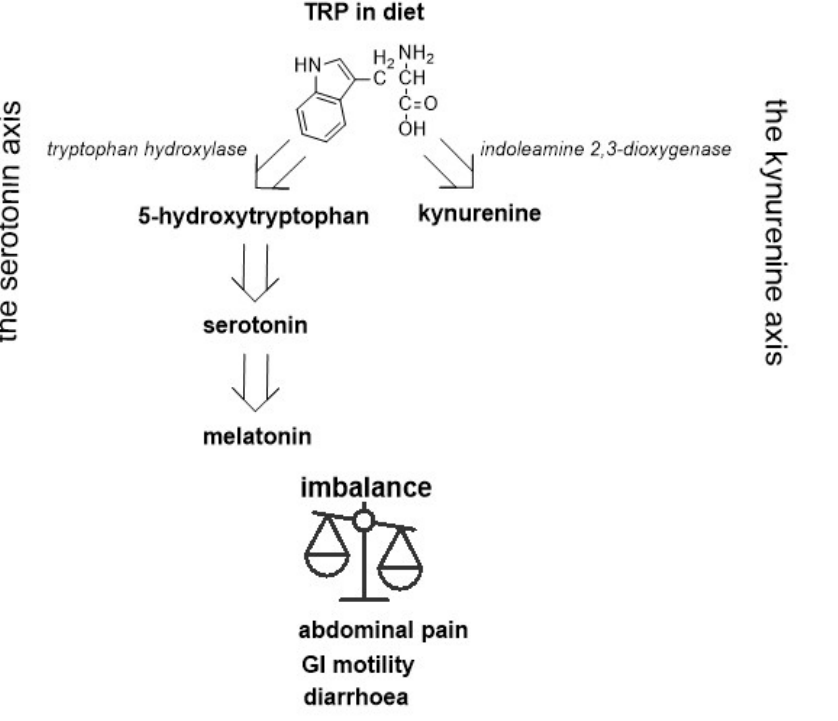
Figure 1. Diagram showing the metabolic pathway involving serotonin in the context of pathophys- iology of IBS.